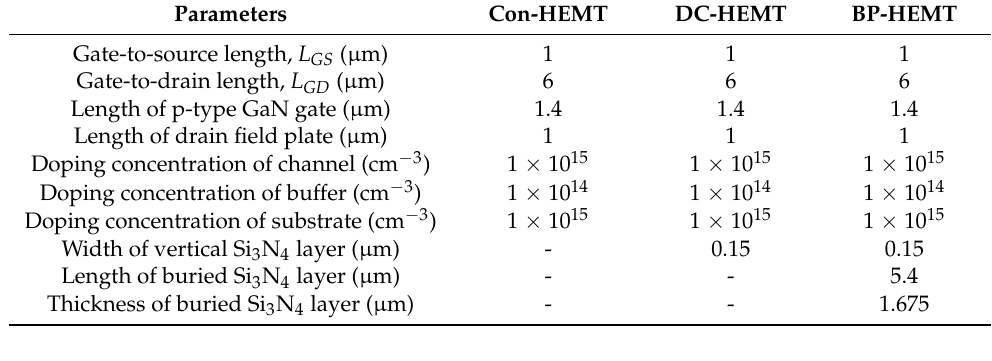
Table 1. Parameters of Con, Dc, and Proposed BP-HEMT.